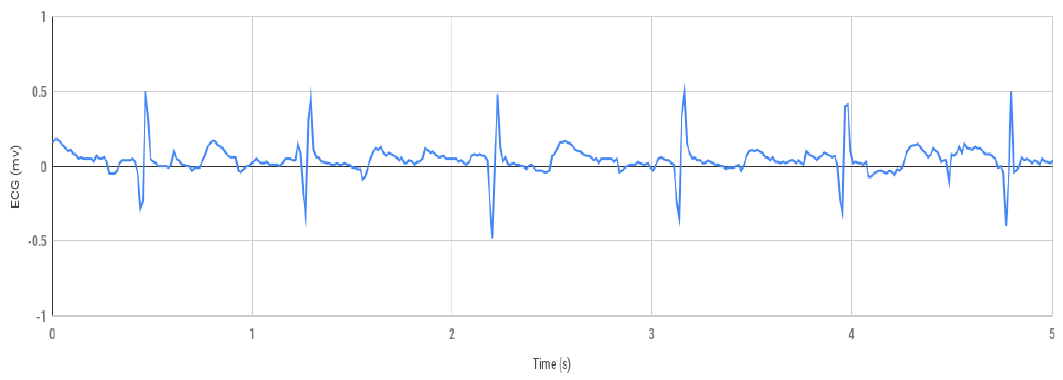
Figure 4. Consistent ECG signal obtained from the Arduino serial monitor.